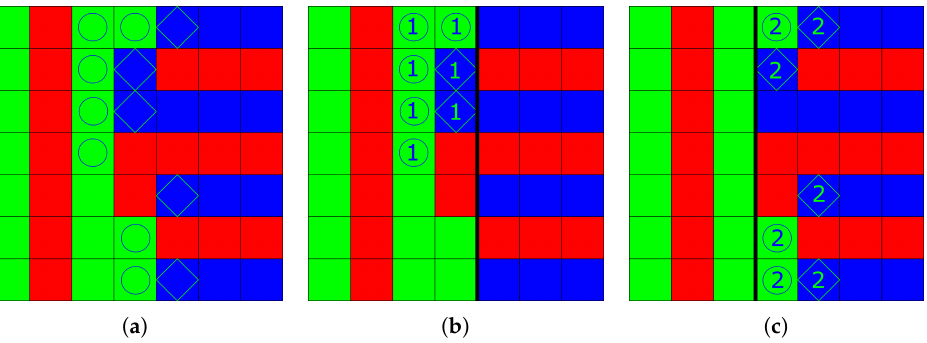
Figure 2. Examples of two aura sets in a color image. ( a ) Original image composed of 3 color site sets, S R , S G , and S B , and aura sets A S ( left ) and P 2 ( right ), and aura sets A 1 S ( c ) Superpixels P 1 ( left ) and P 2 ( right ), and aura sets A 2 S ( S ) are A 1 G S B